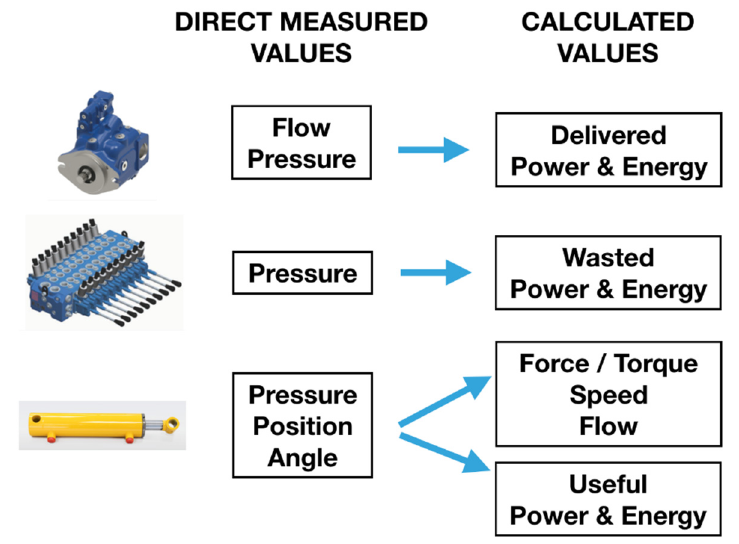
Figure 3. Direct measured and calculated values.